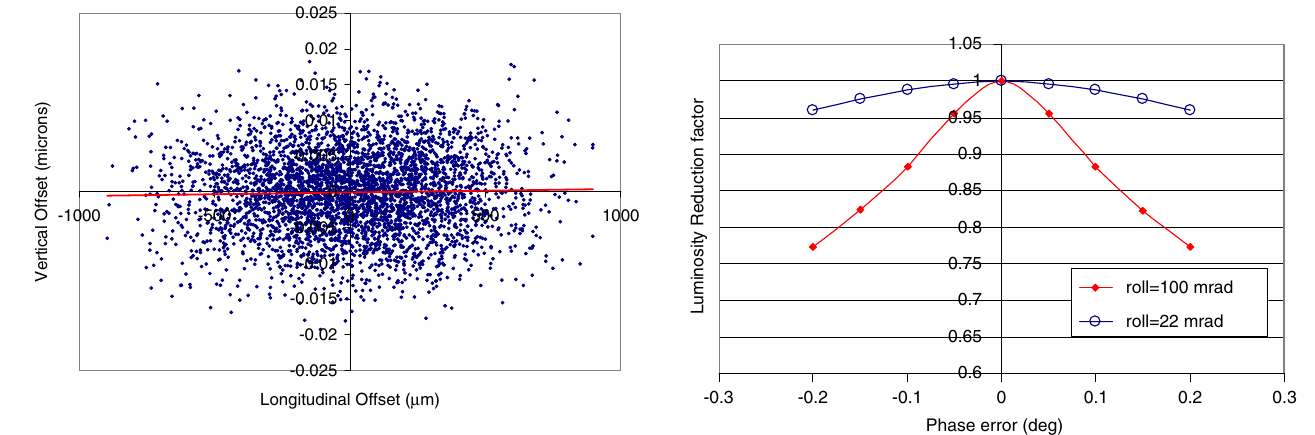
FIG. 9. (Color) Luminosity reduction factor as a function of the phase error on one anticrab cavity for various roll misalignments of the ILC crab